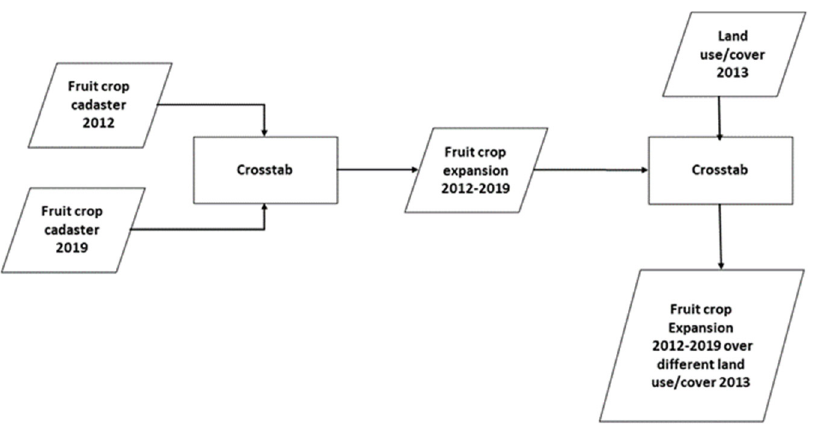
Figure 2. Workflow to obtain fruit crop expansion and which land use/cover was replaced by this expansion.